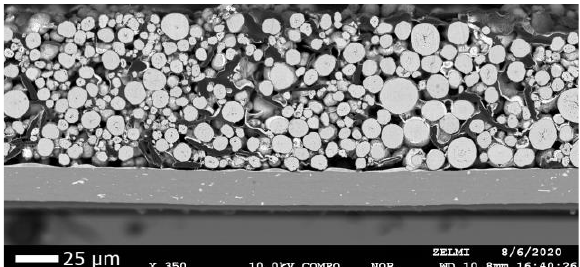
Figure 2. High-resolution image of a positive NMC 111 lithium-ion battery cathode obtained by the backscattered electron signal of a microprobe analysis, acceleration voltage: 10 kV.